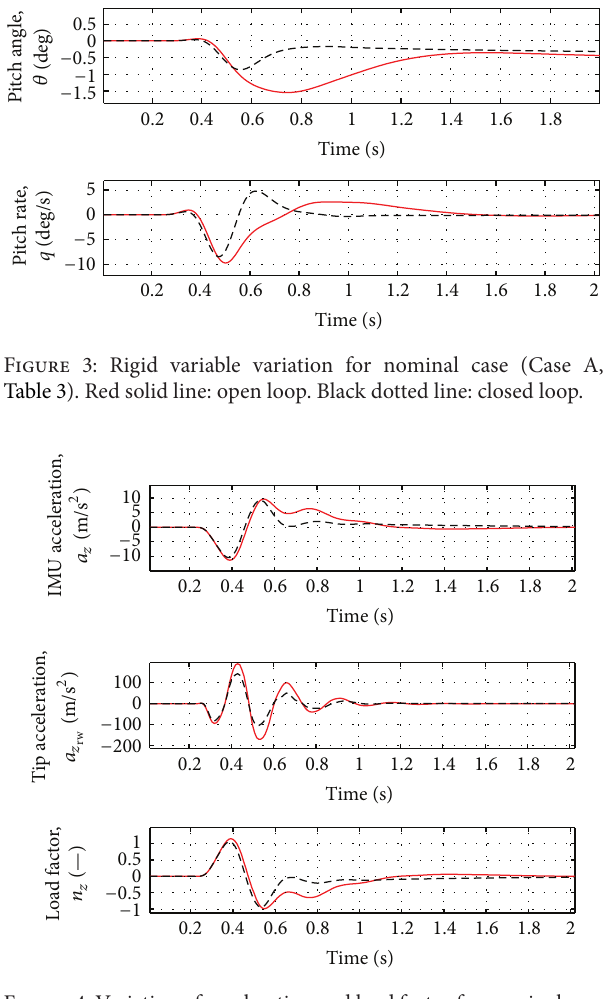
Figure 4: Variation of acceleration and load factor for nominal case (Case A, Table 3). Red solid line: open loop. Black dotted line: closed